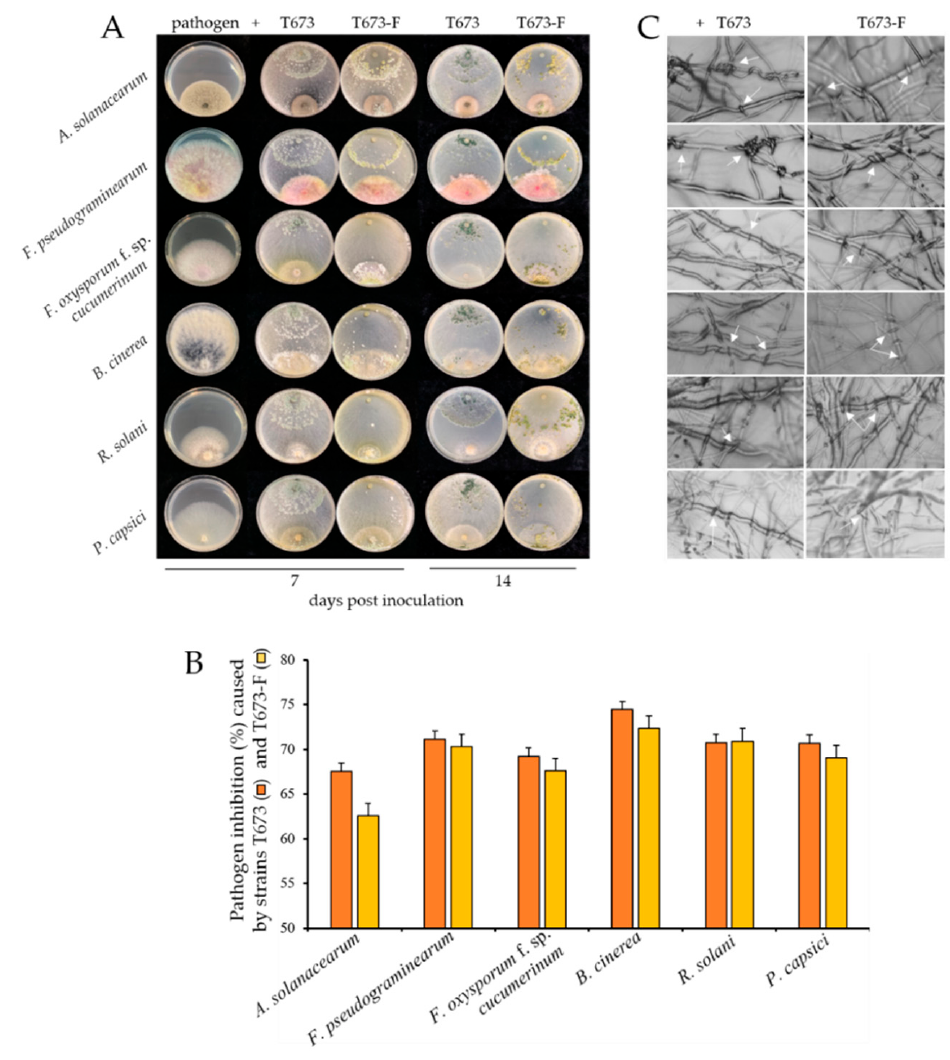
Figure 6. Antagonistic effects of T. harzianum strains T673 and T673-F against six plant pathogens. ( A ): Plate assays show that on PDA plates without the antagonist, the pathogens covered large areas of the plate at 7 dpi. When virus-infected or cured Trichoderma strains were co-inoculated with the pathogens, the area covered by the mycelia of the pathogens was clearly reduced. ( B ): Quantification of inhibitory effects of T. harzianum strains T673 and T673-F. Colony diameters were measured at 7 dpi. Bars indicate standard deviations. ( C ): Microscopy shows extensive coiling of hyphae of pathogens (arrows) by hyphae of ThPV2-infected and -cured Trichoderma strains in all interactions analyzed. In summary, we conclude that ThPV2 infection does not impair but may even